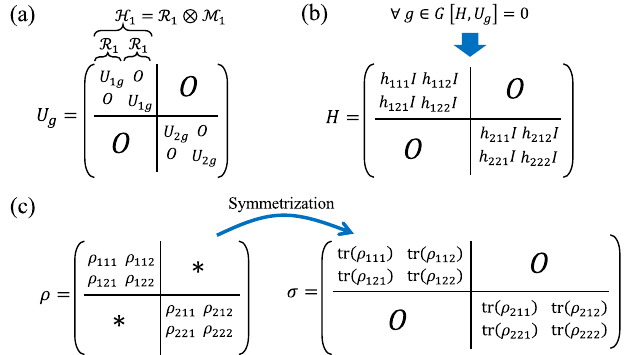
FIG. 5. (a) Schematic of the irreducible decomposition of a unitary representation. (b) The corresponding form of a sym- metry-respecting Hamiltonian. (c) The effective density operator corresponding to the irreducible